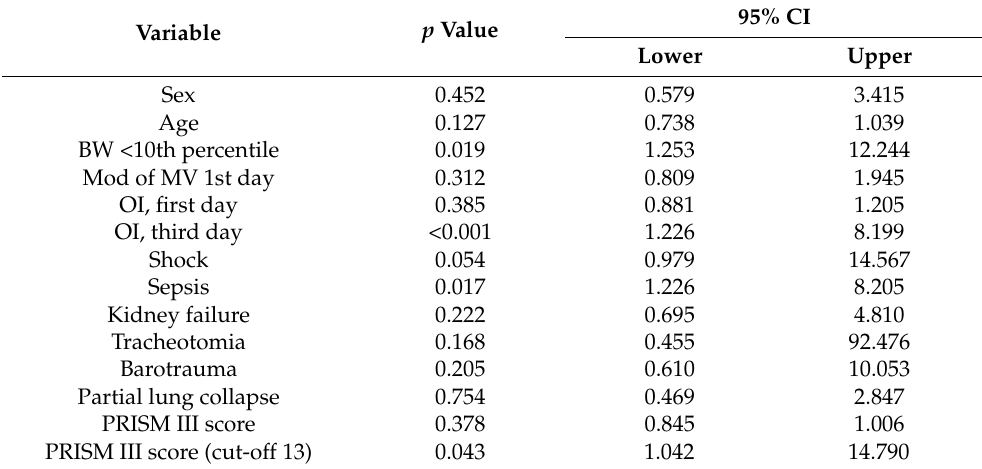
Table 3. Indicators for outcome in PARDS on mechanical ventilation (COX regression